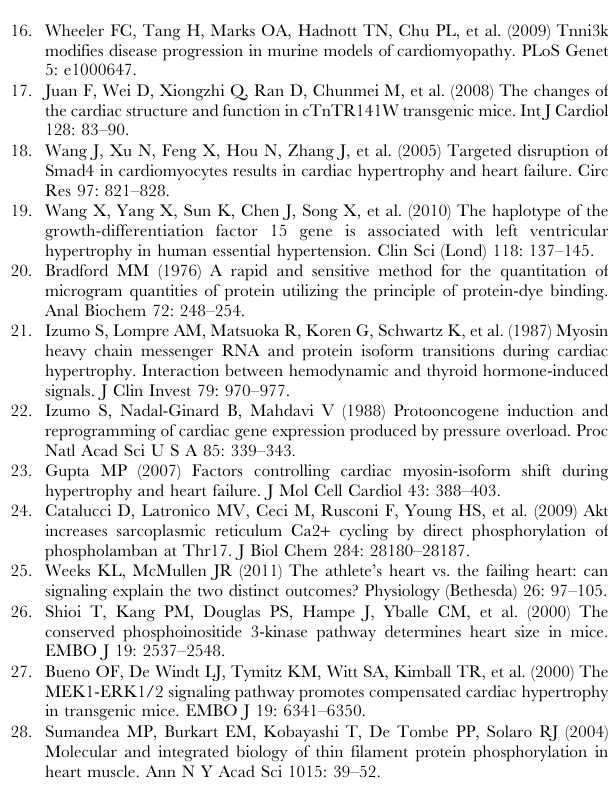
Figure S1 Schematic M-mode echocardiographic trac- ings of TG-H and non-transgenic littermates at the age of 3 month. LVEDD: LV end-diastolic diameter, LVPWD: LV posterior wall thickness in diastole, IVSD: interventricular septum thickness in diastole. (TIF) Table S1 List of real-time PCR primers for rat and mouse. (DOC)